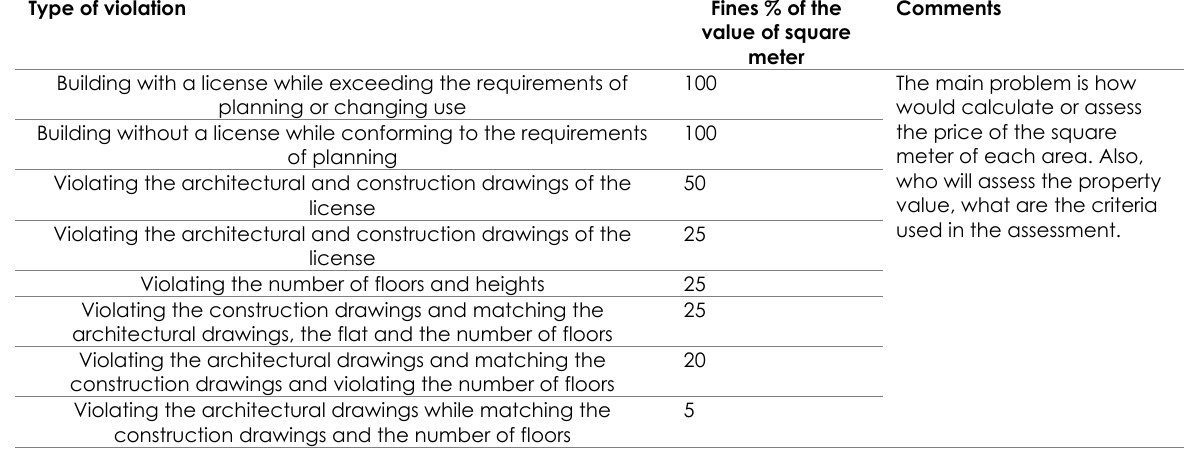
Table 1. The estimated value of fines of the meter price in the area. Type of